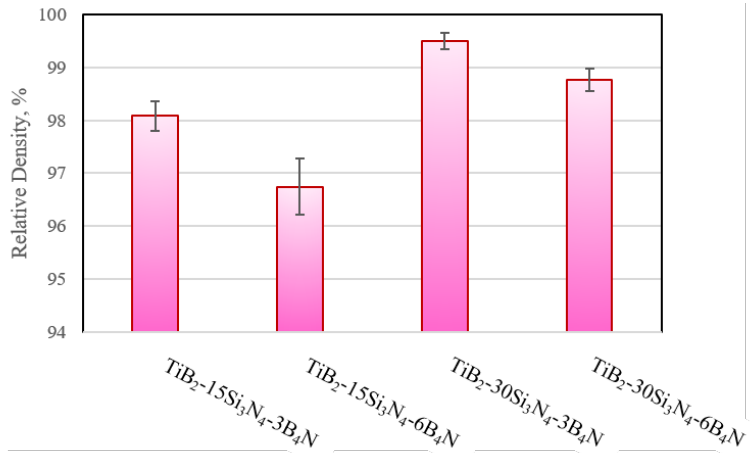
Figure 7. Sintered composites ’ relative